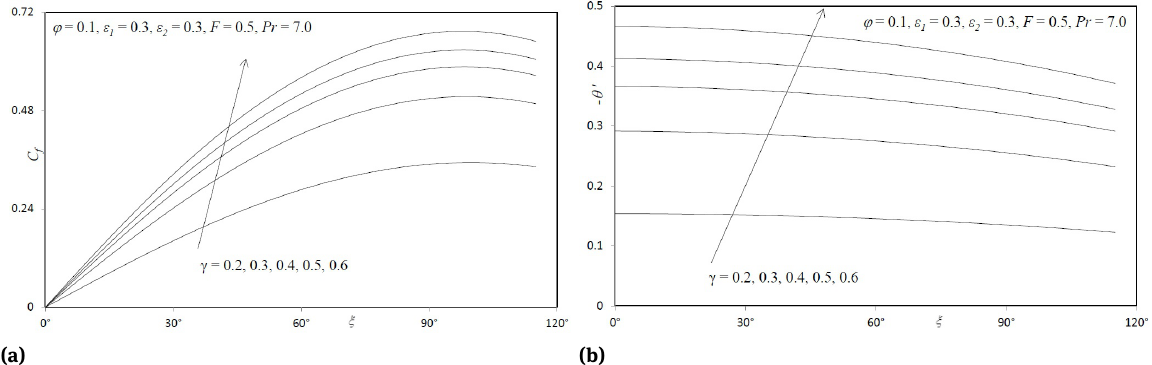
Fig. 12: (a) Effect of γ on Skin Friction; (b) Effect of γ on Nusselt number